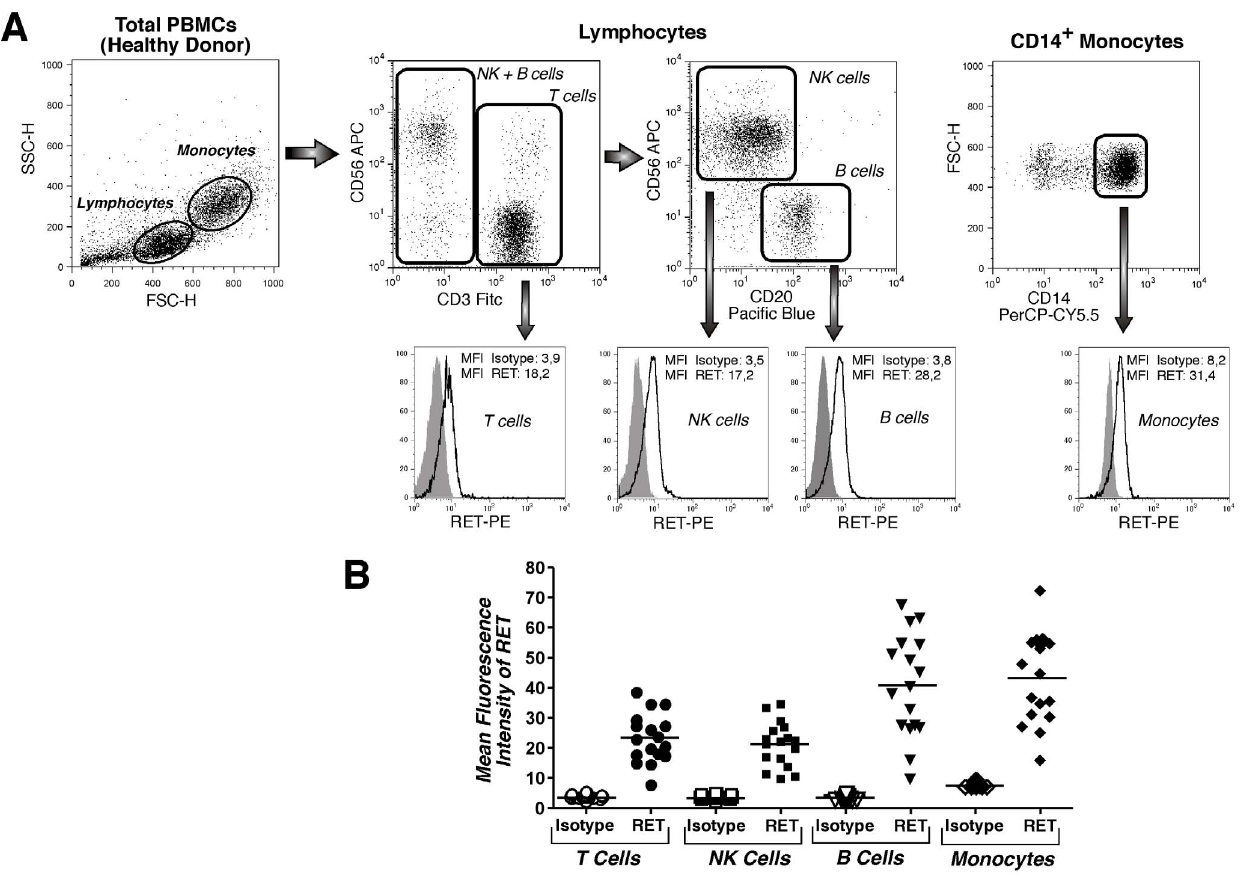
Figure 1. Phenotypic distribution and levels of expression of RET receptor on circulating immune cell subsets. (A) Flow cytometric dot plot (upper line) and histogram (lower line) graphs showing a representative example from an healthy donor of CD14 pos monocytes, CD56 pos (NK cells), CD3 pos (T cells) and CD20 pos (B cells) lymphocytes expressing RET receptor (black line) compared to isotype control (gray shaded histograms). (B) Summary graph of dot plots with medians (horizontal black bars) showing the mean fluorescence intensities (MFIs) of RET receptor on immune cells (black symbols) compared to that of isotype controls (open white symbols) from 17 healthy donors.